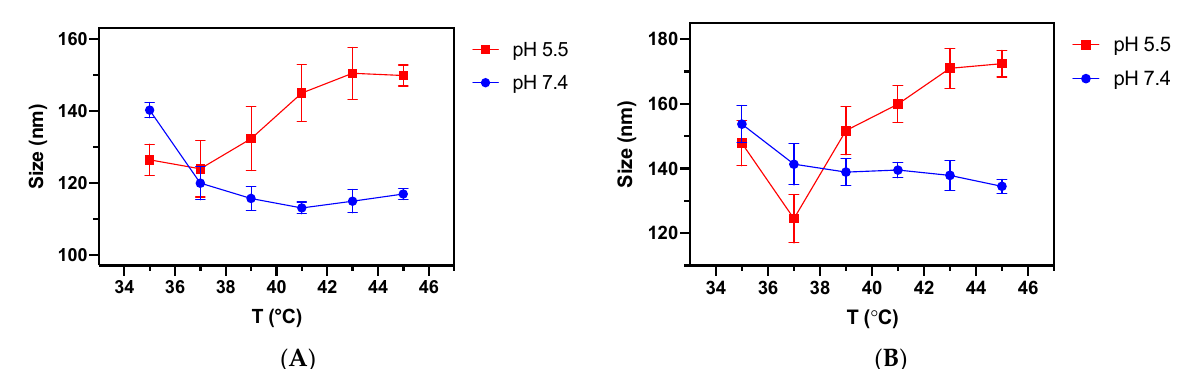
Figure 15. Size variation of DOX-loaded SMLs with increasing temperature at different pH values. ( A ) DPPC SMLs; ( B ) DPPC/DSPE-PEG SMLs. Mean size values and standard deviation are from triplicate assays.